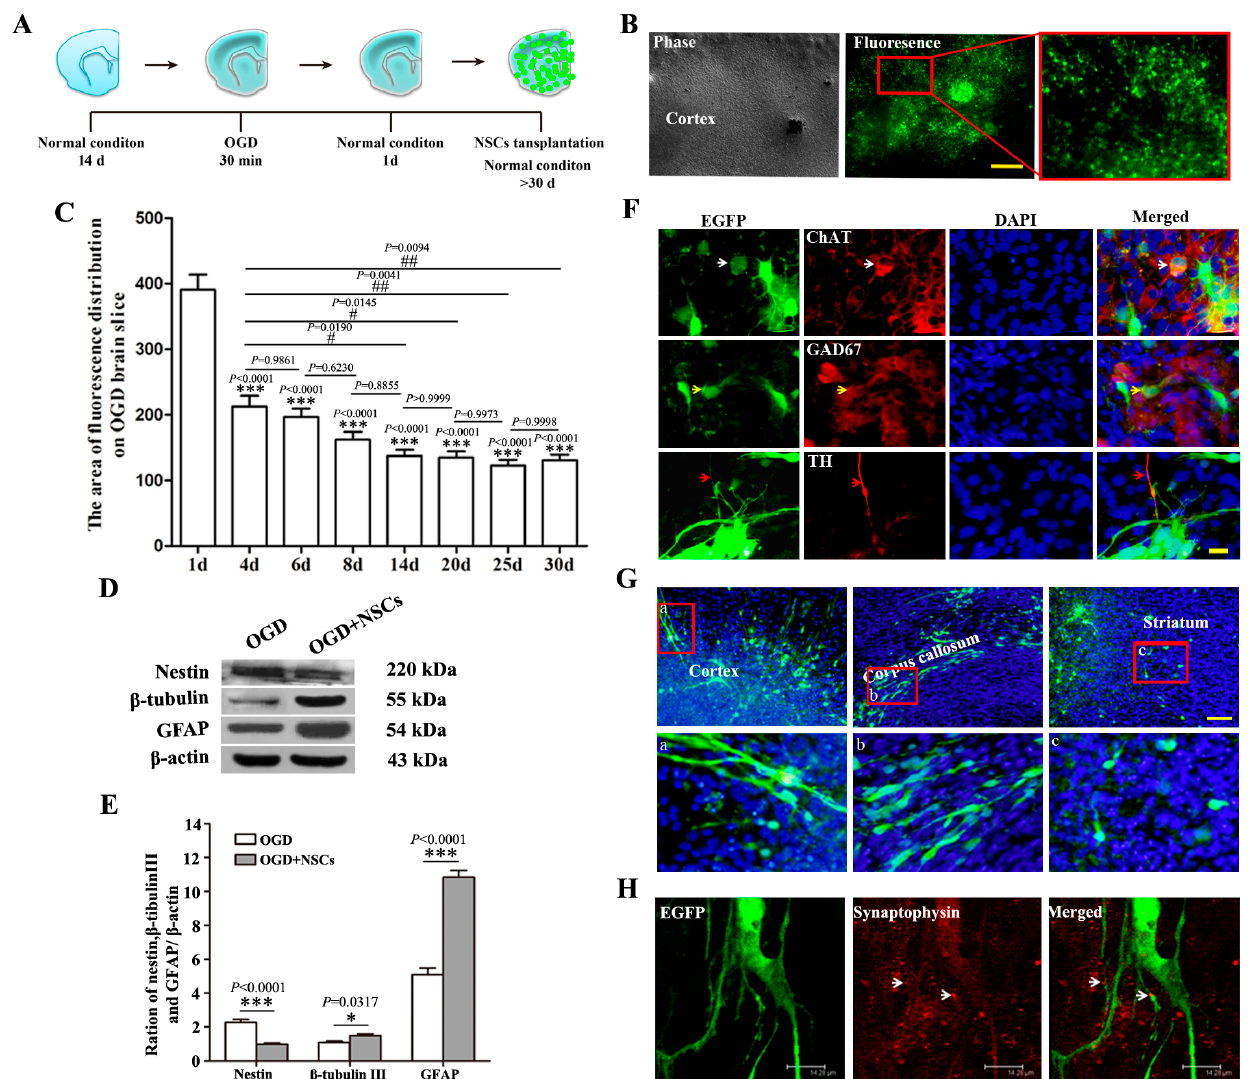
Figure 3. The biological behaviors of transplanted NSCs on host organotypic brain slices under OGD conditions. ( A ): The schematic diagram of transplantation of NSCs on OGD brain slices. ( B , C ): The survival of transplanted NSCs on cerebral cortex of brain slice after OGD treatment. Red box: the zoomed-in region. Scalar bar = 500 µ m. The values are mean ± SE. *** p < 0.001 in comparison with 1d; # p < 0.05, ## p < 0.01 in comparison with 4d, n = 5. ( D , E ): The expression of nestin, β - tubulin III and GFAP. The values are mean ± SE. * p < 0.05, *** p < 0.001, n = 5. ( F ): Transplanted NSCs differentiated to ChAT (white arrow)-, GAD67 (yellow arrow)- and TH (red arrow)-positive neurons. Scalar bar = 20 µ m. ( G ): Different migration patterns of transplanted NSCs on cerebral cortex, striatum and corpus callosum. Red boxes: the zoomed-in regions. (a) Cortex; (b) Corpus callosum; (c) Striatum. Scalar bar = 100 µ m. ( H ): The potential synaptic connections between transplanted NSCs and host cells. White arrows: synaptophysin protein expressed in EGFP-positive cells. Scalar bar = 18.75 µ